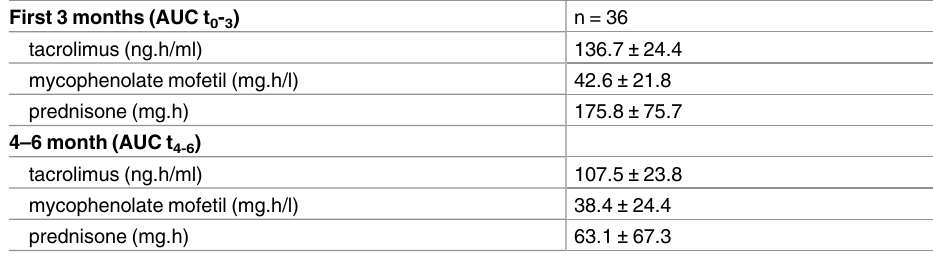
Table 2. Area under the curve of immunosuppressants.